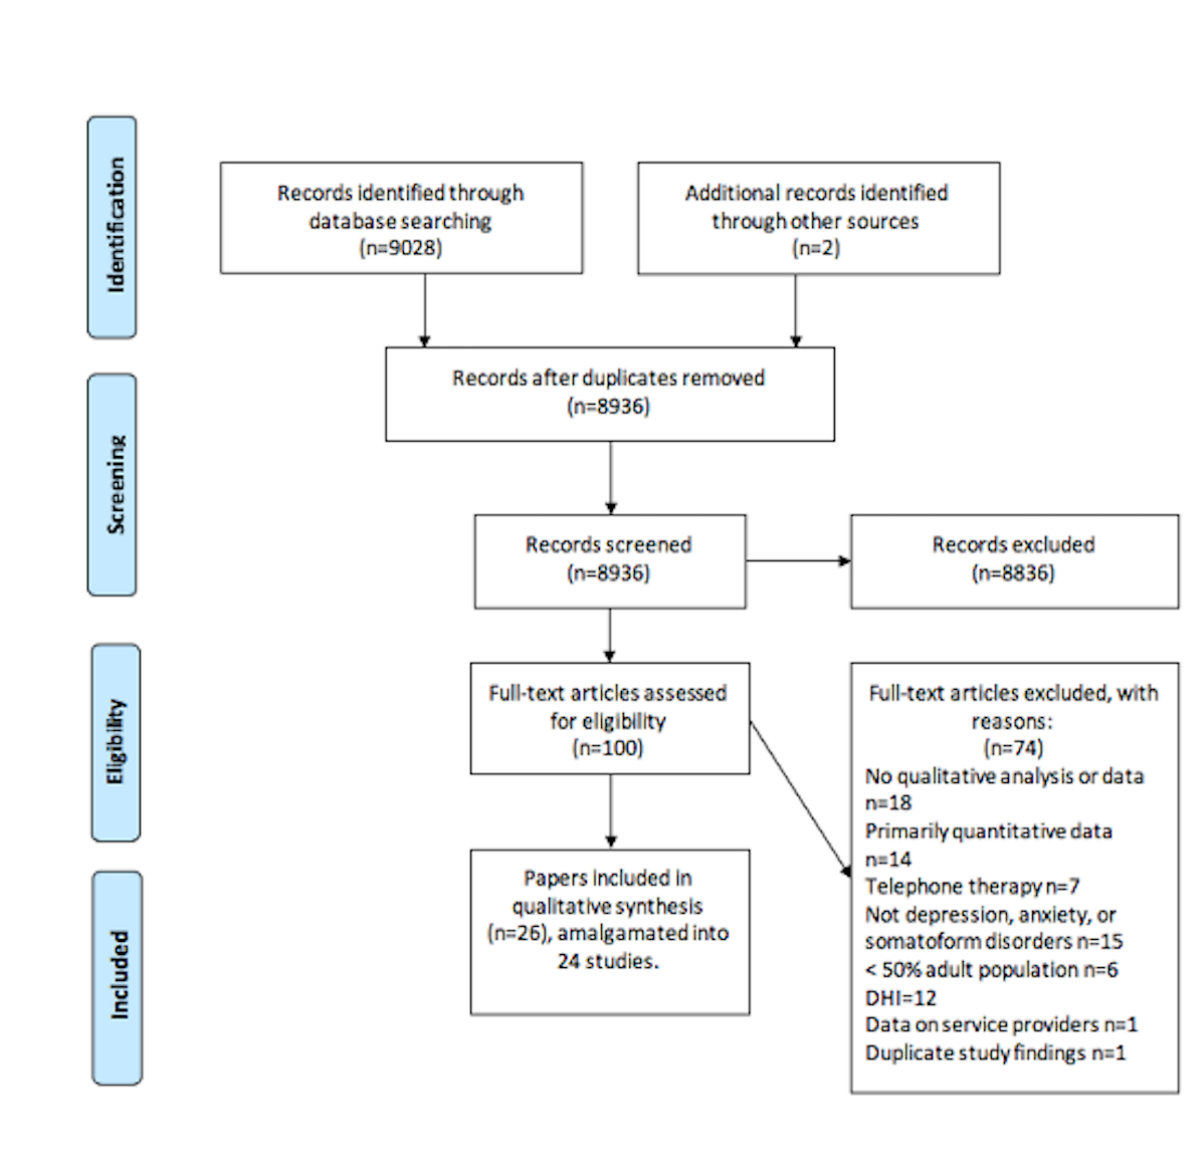
Figure 1. Flow diagram of study identification and selection adapted from Preferred Reporting Items for Systematic Review and Meta-Analyses